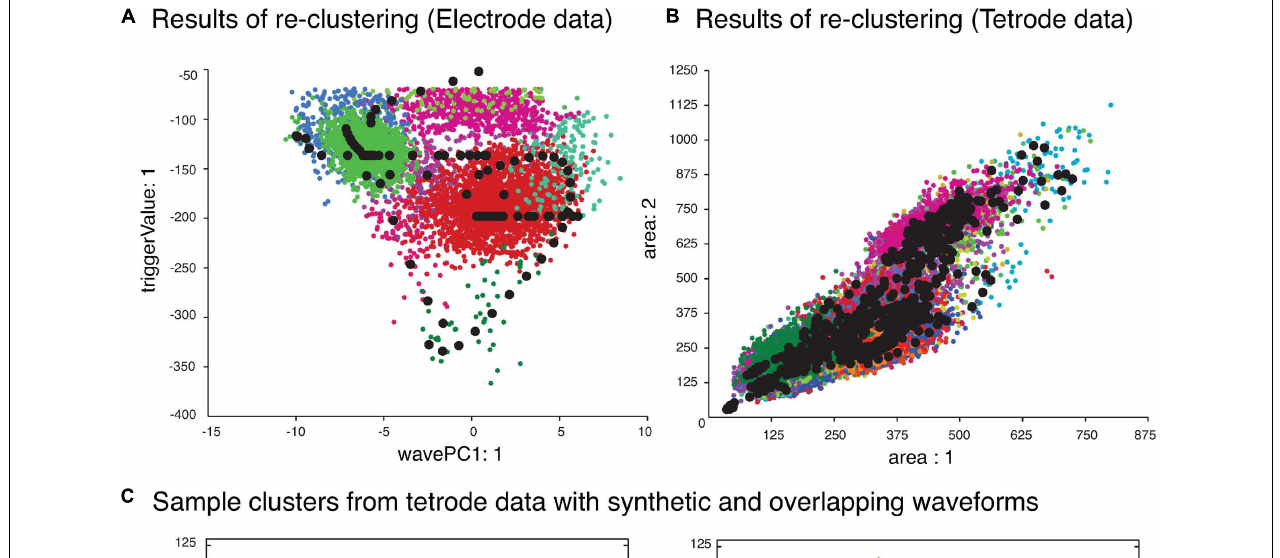
possible synthetic waveforms, this could have incorrectly grouped waveforms with similar time courses but different